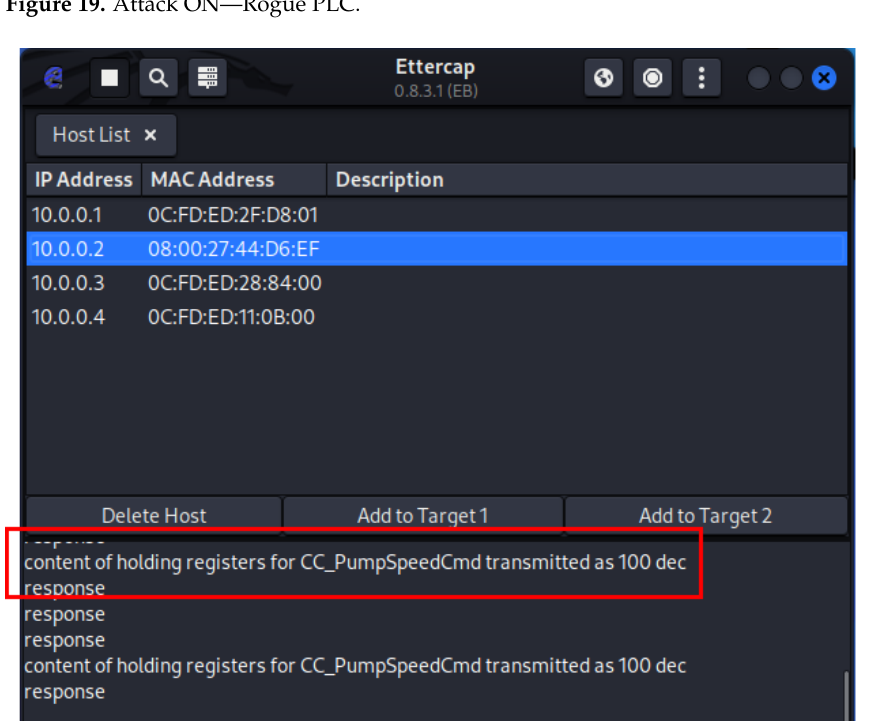
Figure 19. Attack ON—Rogue PLC.